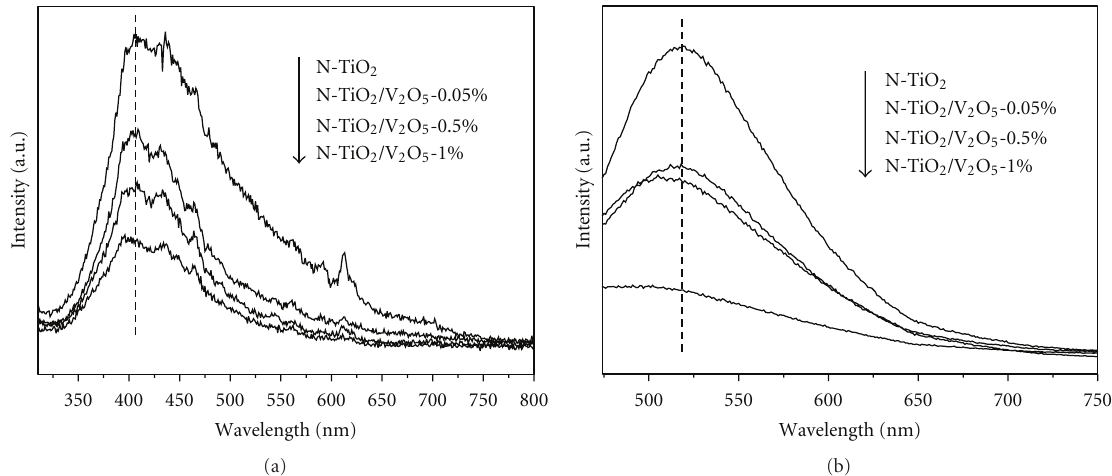
Figure 6: PL spectra of N-TiO 2 and selected V 2 O 5 cluster modified N-TiO 2 samples under the excitation of 300nm light (a) and 425 nm light (b).